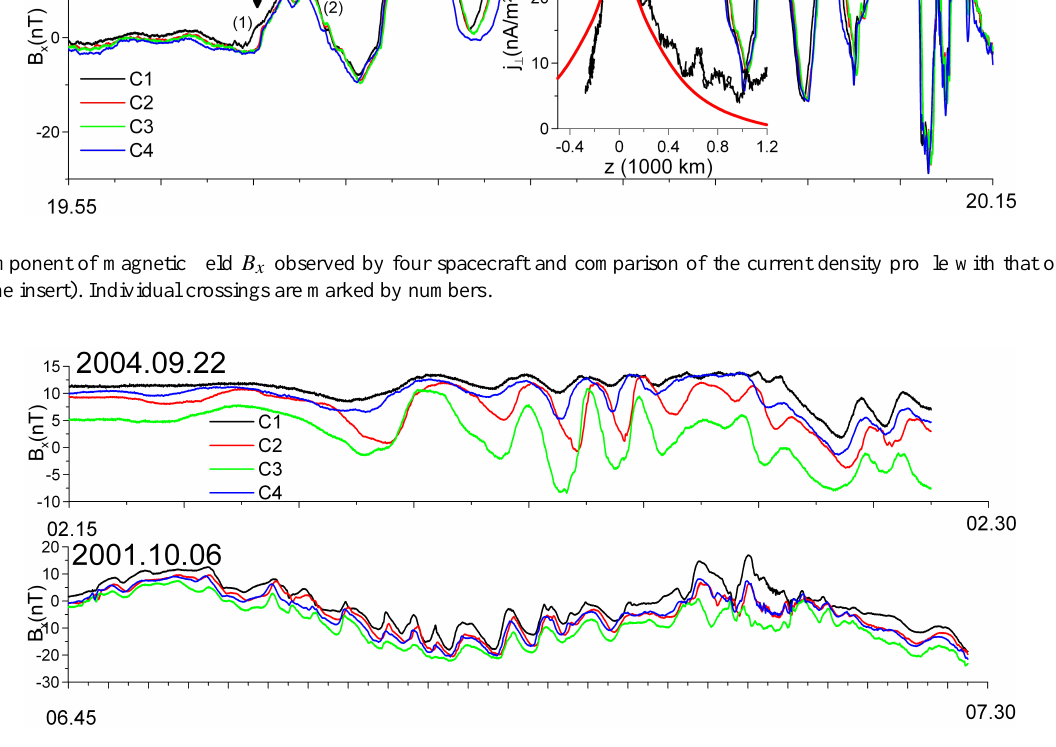
Fig. 5. Two other examples of wavy events (see the text for